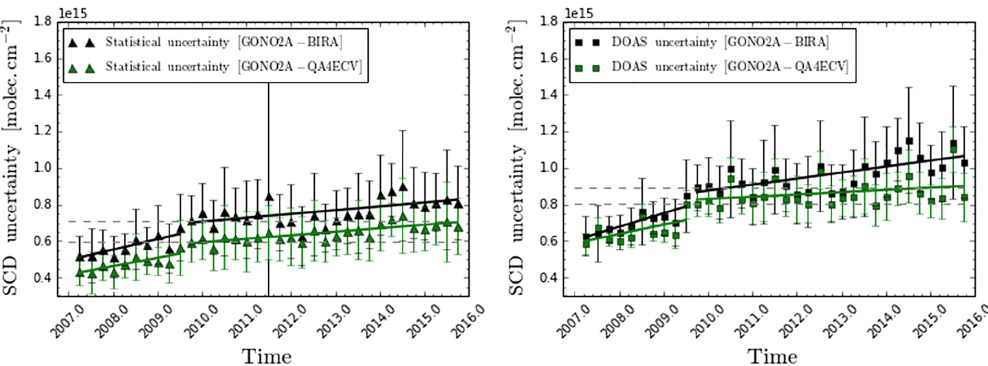
Figure 11. Temporal evolution of the statistical (triangles) and DOAS (squares) GOME-2A NO 2 SCD uncertainty for the sub-periods before and after the second throughput test (September 2009) for GONO2A-BIRA (black) and GONO2A–QA4ECV (green) (Pacific orbit from day 1 of January, April, August, October or, closest available data, 2007–2015). Error bars represent 1 standard deviation (1 σ) . Solid lines represent the linear regressions fitted to the data for each sub-period (Table 7). The slope, p , of each fit on the statistical, p s , and DOAS uncertainty, p d , before the test is = 0 . 057 × 10 15 ± 0 . 017 × 10 15 molec.cm − 2 year − 1 and p d = 0 . 074 × 10 15 ± 0 . 019 × 10 15 molec.cm − 2 year − 1 p s bira bira